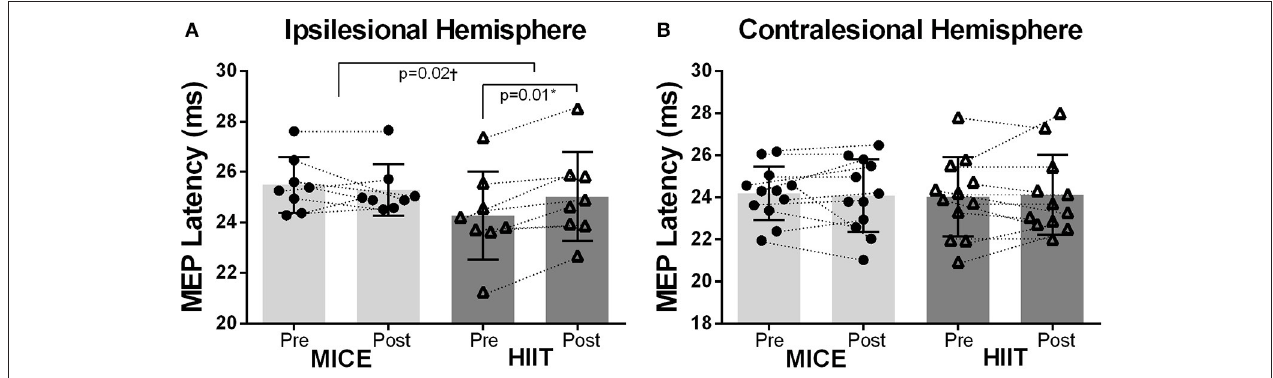
FIGURE 2 | Changes in MEP latency following exercise. (A) There was a significant difference in MEP latency changes between MICE and HIIT in the ipsilesional hemisphere. MEPs were conducted slower after HIIT but not after MICE. (B) There were no changes in the contralesional hemisphere. *Significant pre and post MEP